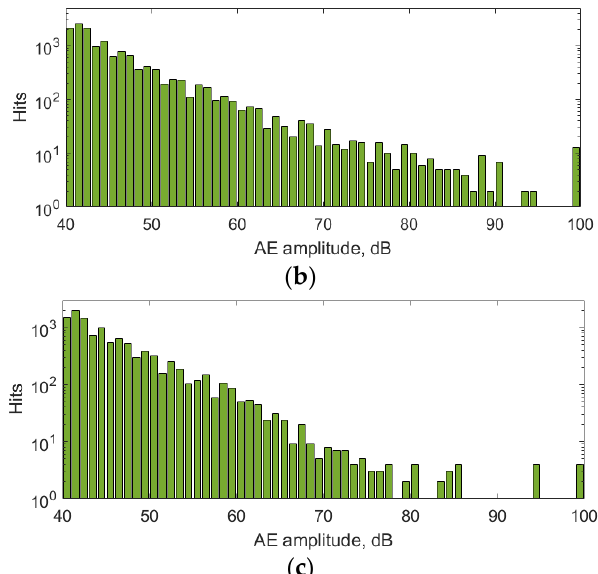
Figure 3. Maximum amplitude distribution of AE pulses registered during the quasi-static uniaxial tension of woven laminate samples (( a ) warp, ( b ) weft) and unidirectional CFRP samples ( c ). The distribution slopes for the woven laminate samples cut along the warp and weft directions are the same, while, in the case of unidirectional CFRP, the slope becomes steeper due to a relative decrease in high-amplitude signals. Although the low-amplitude pulses are prevalent in the recorded signals, the medium- and high-amplitude AE pulses can be registered long before fracture, starting from the middle of the first acoustic emission activity stage in each of the three experiments (Figure 4).